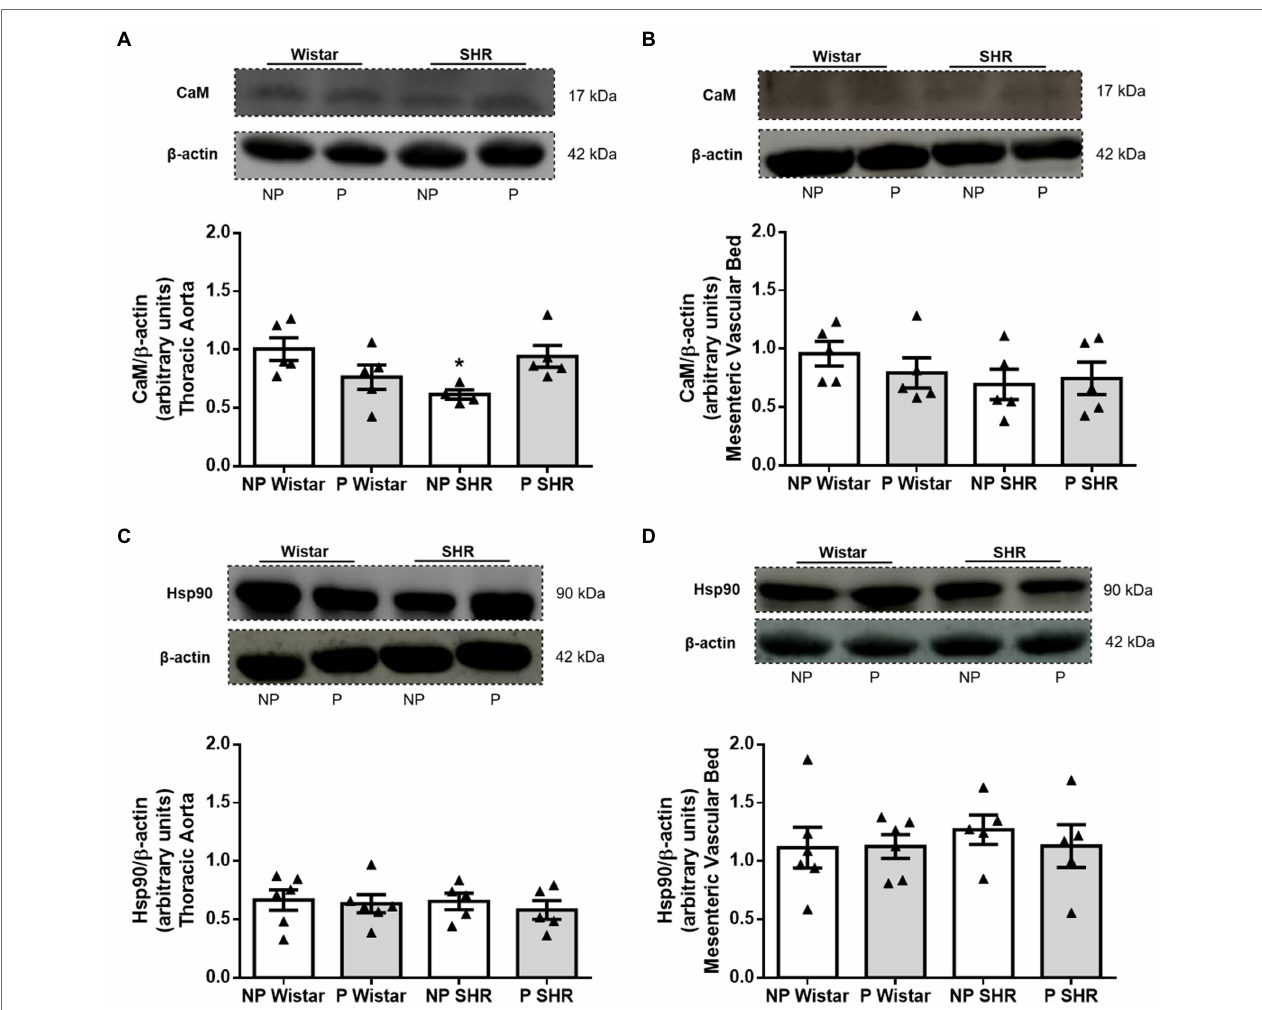
FIGURE 6 | Representative images and quantification of calmodulin (CaM)/ β -actin and heat shock protein 90 (Hsp90)/ β -actin expression in the aorta (in A,C ) and resistance mesenteric bed (in B,D ) homogenates from non-pregnant (NP) and pregnant (P) Wistar and spontaneously hypertensive (SHR) rats. The bars represent the mean ± SEM of the results obtained in the aorta and resistance mesenteric bed ( n = 5–6) from the different groups. * p < 0.05 NP SHR versus NP Wistar